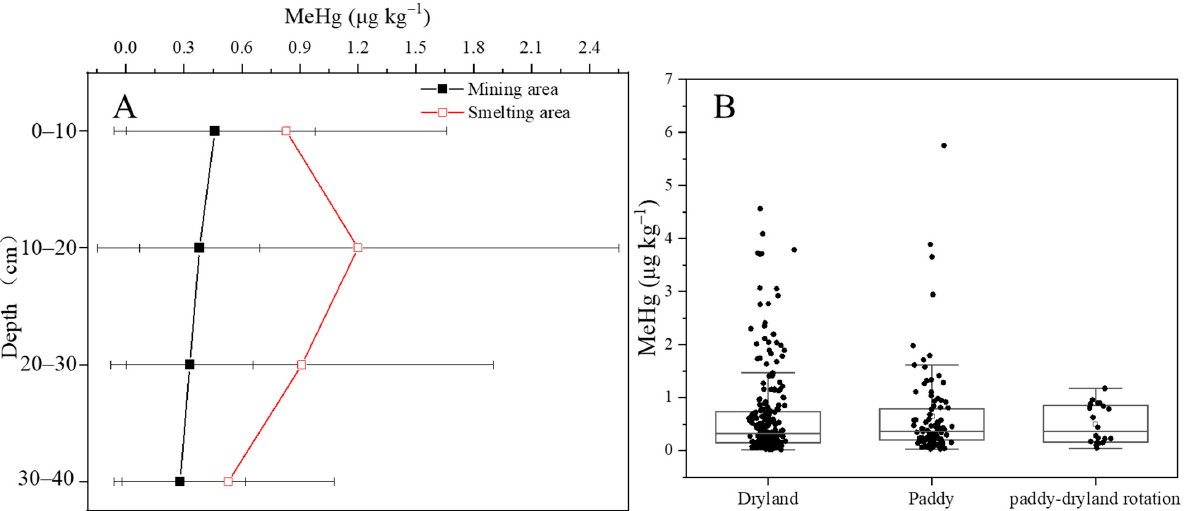
Figure 5. Distribution of MeHg in soil in different profiles ( A ) and land-used styles ( B ). In the mining area, the MeHg concentrations in the dryland, paddy, and paddy-up- land rotation soils were 0.36 ± 0.31, 0.73 ± 1.09, and 0.71 ± 0.42 μ g kg − 1 , respectively (Figure 5B). By contrast, in the smelting area, the MeHg concentrations in the dryland and paddy soils were 0.95 ± 0.95 and 0.65 ± 0.59 μ g kg − 1 , respectively (Figure 5B). Paddy fields had the highest concentrations in the mining area, but drylands had the highest concentrations in the smelting area. These results indicate that different industrial activities have resulted in a complex accumulation of MeHg in farmland soil. Higher Hg methylation occurs in flooded paddies than in dryland areas [30], and we speculate that the MeHg input from water irrigation is an important source of MeHg in the soil. 3.4. Effects of Soil Properties on Hg Distribution In the mining area, total Hg showed significant relationships with pH, Mn, and CEC but no relationship with SOM (Figure 6A). By contrast, in the smelting area, total Hg had significant relationships with Mn and CEC but no relationship with pH and SOM (Figure 6B). Both Hg and Mn in farmland soils may have similar sources, such as Mn/Hg-contain- ing wastewater [13], which would enhance their relationship in the smelting area. Our results indicate that smelting sources have greater contributions to Mn/Hg than mining sources. Although SOM has a positive role in the accumulation of Hg in soil [31], we could not identify a close relationship in this study. Moreover, because the CEC value reflects the soil cation adsorption capacity [32], we speculated that a high CEC would result in the retention of exogenous Hg in soil. In the mining area, soil MeHg had a positive relationship with the THg concentration, pH, SOM content, CEC, and S concentration but had a negative relationship with the Fe concentration (Figure 6A). However, in the smelting area, soil MeHg only had a positive relationship with the SOM content, and its relationships with the Fe and Mn concentra- tions were negative ( p < 0.05). It had no obvious relationship with the THg concentration (Figure 6B). Although SOM only has a minor role in the accumulation of Hg in soil, it can favor MeHg production by fueling Hg-methylating bacteria [33]. The lack of a relationship between the THg concentration and MeHg in the smelting area was interesting because this area may receive Hg from the electrolytic Mn plant (Figure 6B). The negative relation- ship between Mn and MeHg or %MeHg in the smelting area indicated that Mn released from the electrolytic Mn plant might inhibit Hg methylation in soil. Soil Fe has similar impacts on MeHg production with Mn. This may be because Fe/Mn oxides act as im- portant binding ligands competing for soil Hg [6].